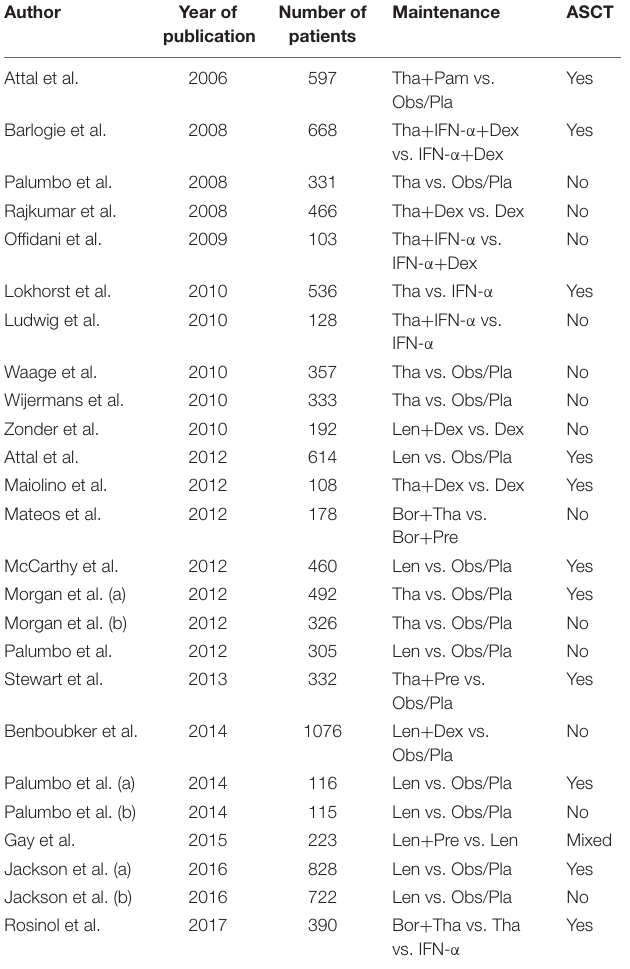
TABLE 1 | Included RCTs and basic